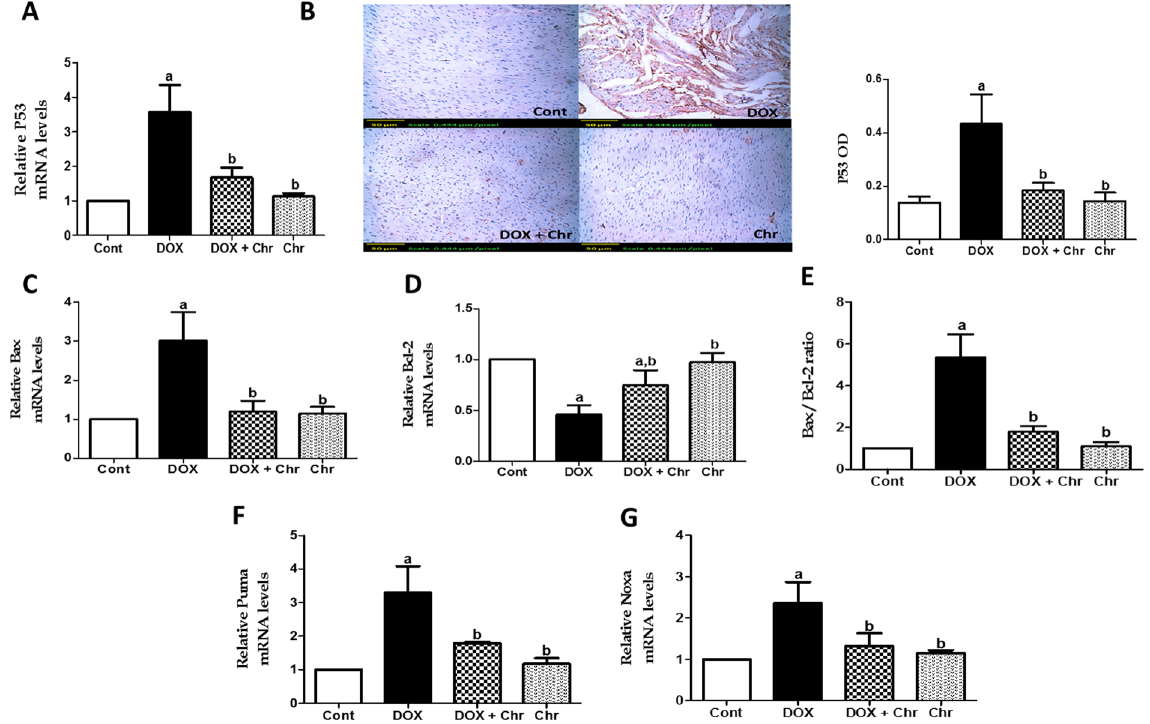
Figure 4. Effect of chrysin on expression of p53 and Bcl-2 family members in rats subjected to chronic doxorubicin (DOX) intoxication. ( A ) Gene expression of p53. ( B ) Protein expression of p53 by immunohistochemical staining. Scale bar, 50 µ m (200x) and quantitative image analysis for immunohistochemical staining was expressed as optical densities (OD) across 10 different fields for each rat section. ( C ) Gene expression of Bax. ( D ) Gene expression of Bcl-2. ( E ) The ratio of Bax to Bcl-2 gene expression. ( F ) Gene expression of Puma G: Gene expression of Noxa. Quantitation of gene expression was done using real- time PCR. The levels of mRNA were normalized to that of GAPDH in each group. The mRNA levels of genes were expressed as relative quantification (RQ) compared to the control group. The value of genes in control group was defined as 1. Data are represented as mean ± SD (n = 10). a or b: Statistically significant from the control or DOX group respectively at P < 0.05 using one-way analysis of variance ANOVA followed by Tukey- Kramer as a post-hoc